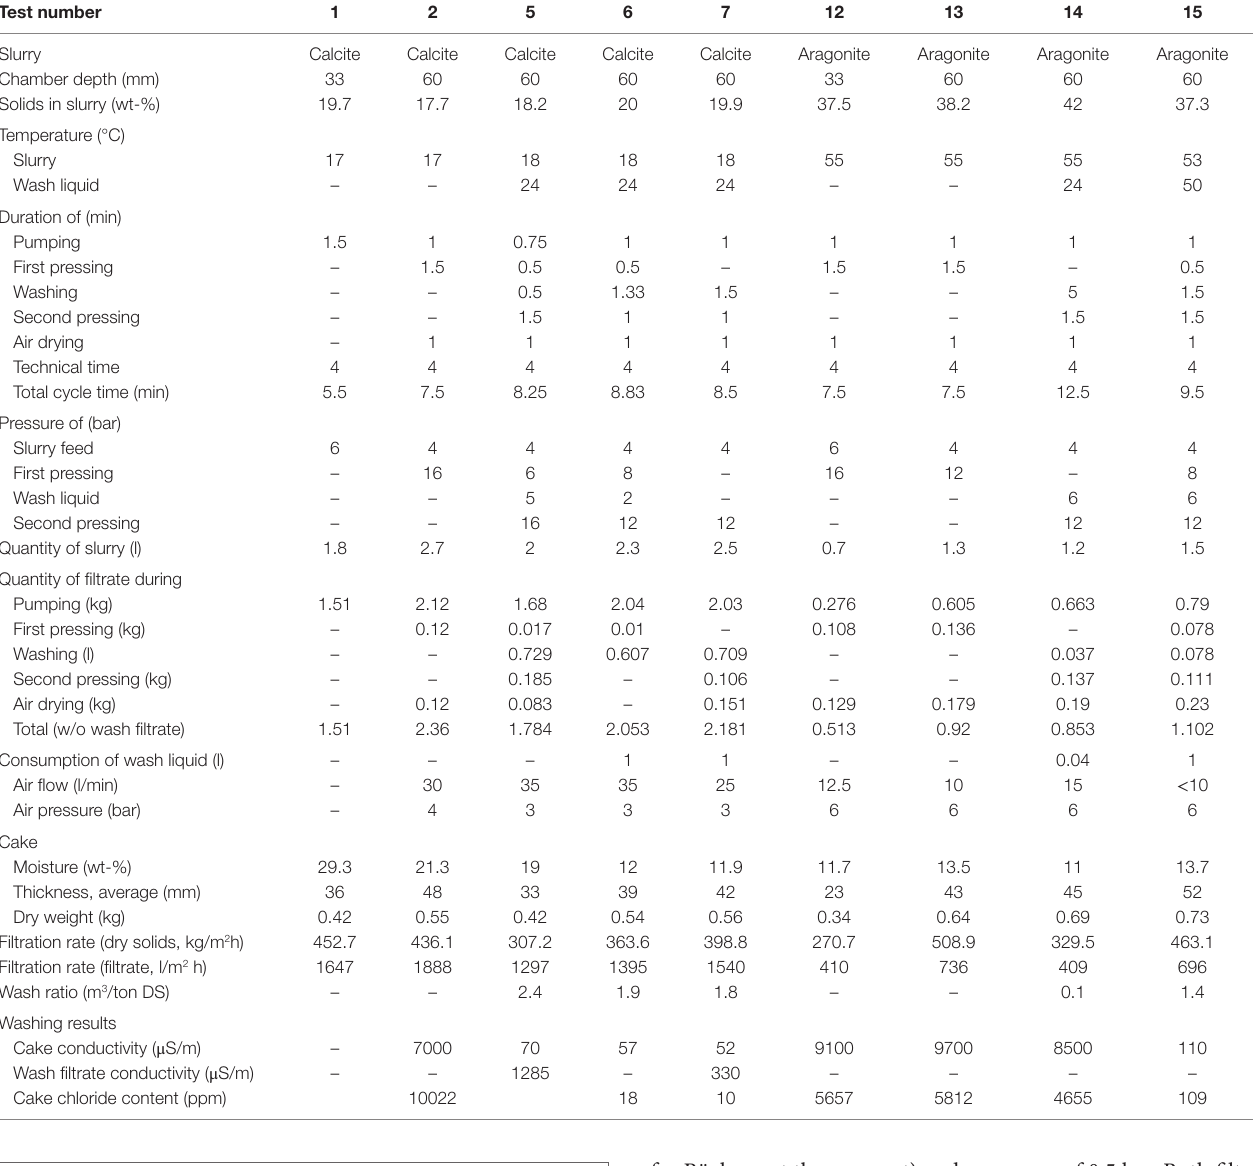
TaBle 5 | Parameters used in the pressure filtration